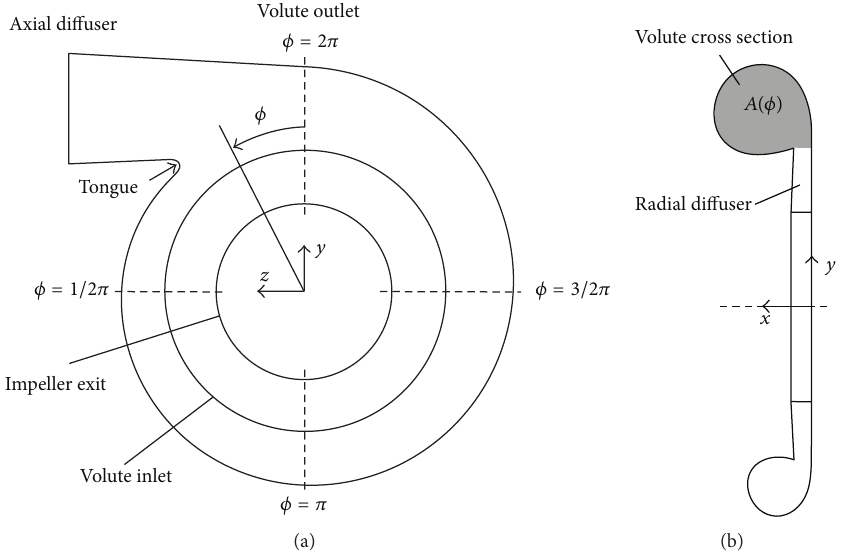
Figure 4: Definition of the volute geometry in top-down view (a) and sectional view through the point of origin